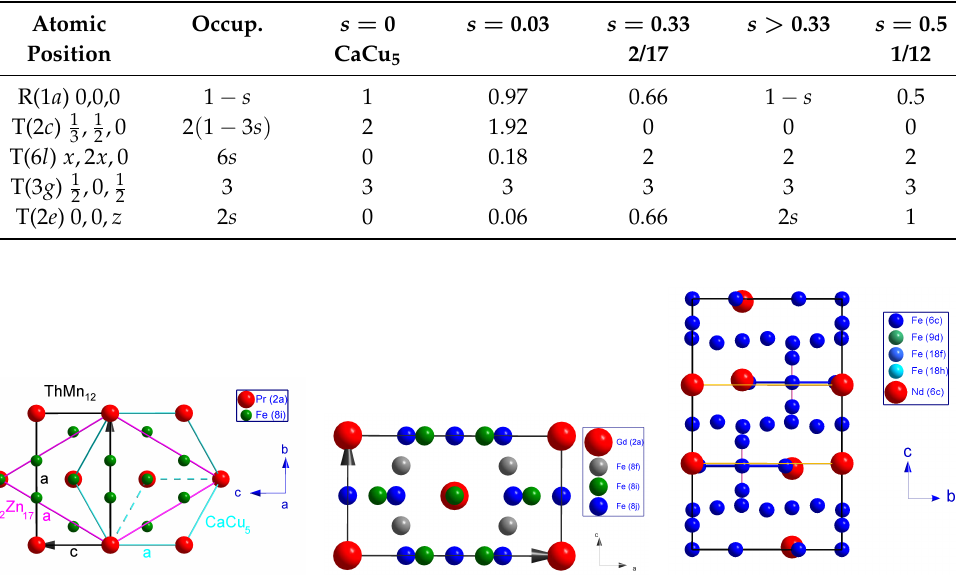
Table 1. Atom Wyckoff positions, number of atoms in hexagonal P 6/ mmm R 1 − s T 5 + 2 s structure. s = 0, s = 0.33, and s = 0.5 correspond to CaCu 5 , Th 2 Zn 17 , and ThMn 12 structure, respectively.